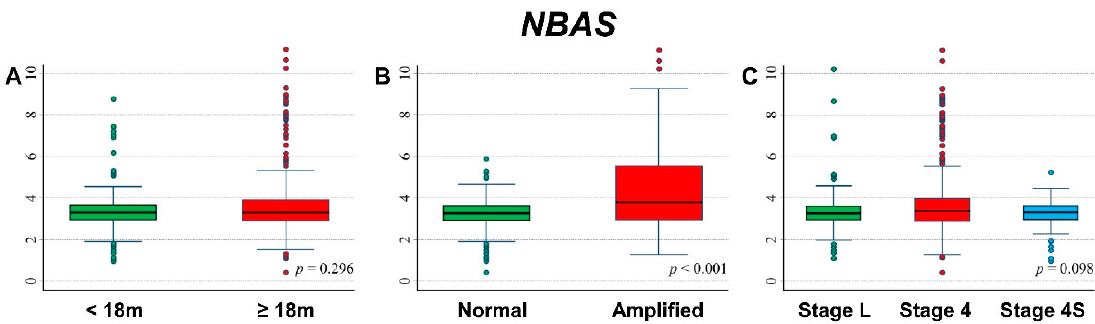
Figure 21. Association between NBAS gene expression and the main patient characteristics at diagnosis. ( A ) Age; ( B ) MYCN status; ( C )